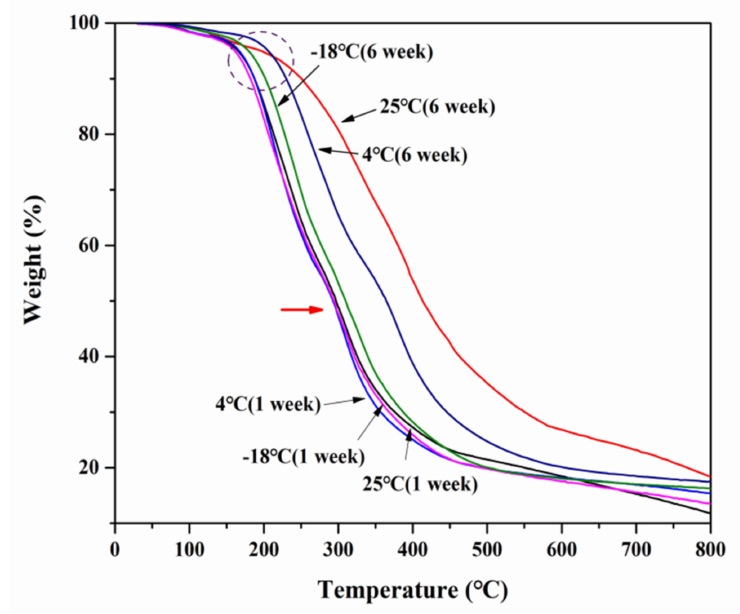
Figure 3. TGA of SPI films at different storage temperatures (25 ◦ C, 4 ◦ C, − 18 ◦